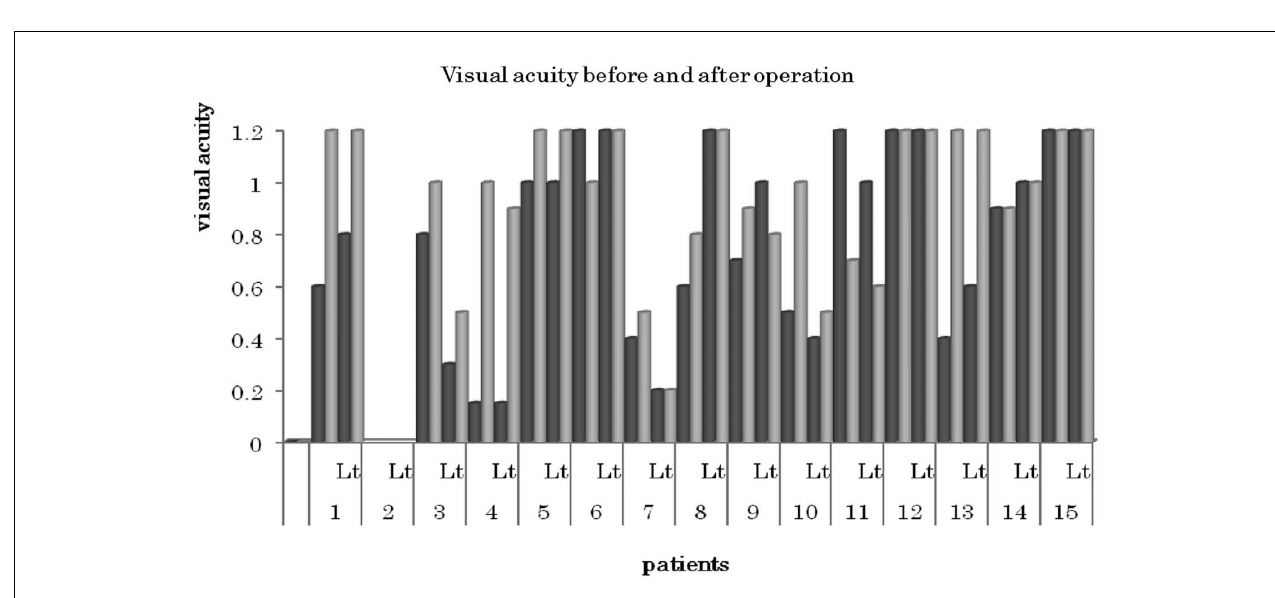
FIGURE 3 |Visual acuity before and after the operation. Black bars: preoperative visual acuity; gray bars: postoperative visual acuity.